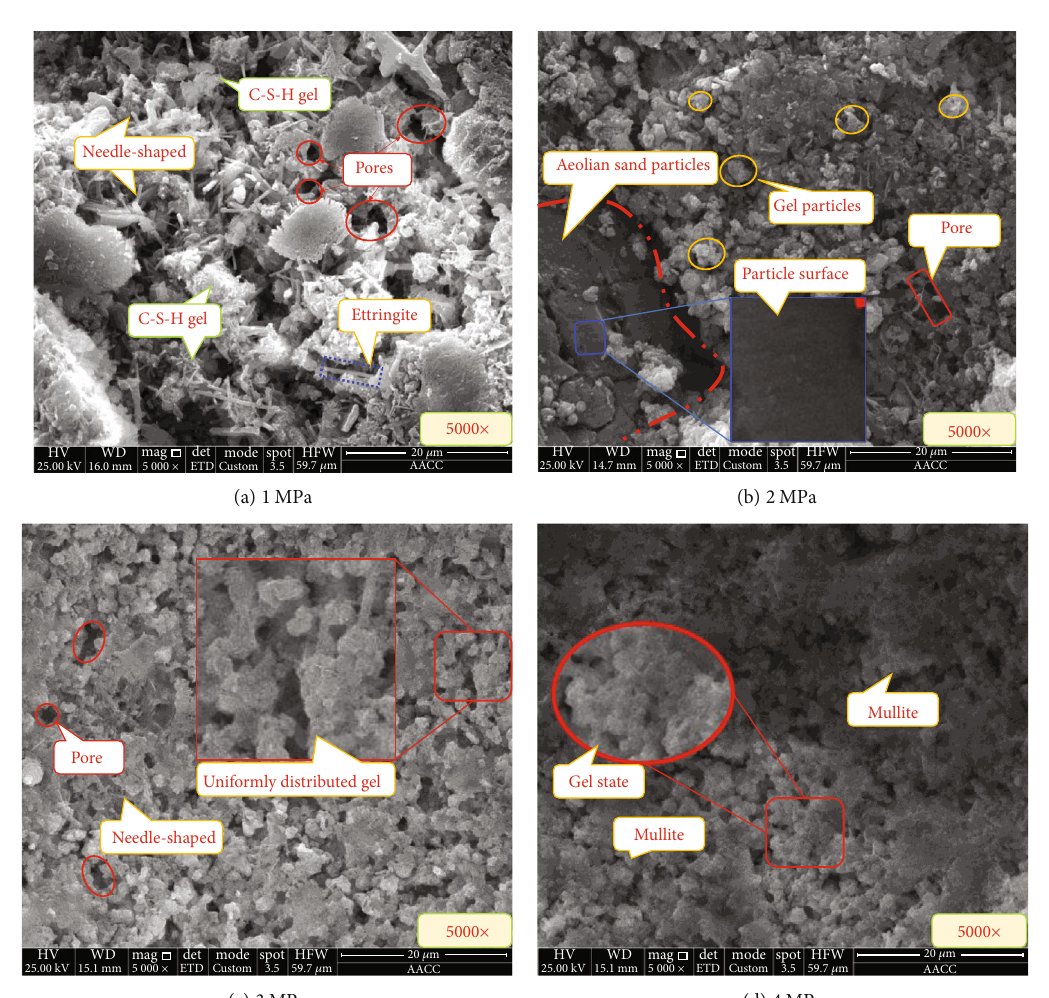
Figure 11: SEM patterns of SBCB under di ff erent con fi ning